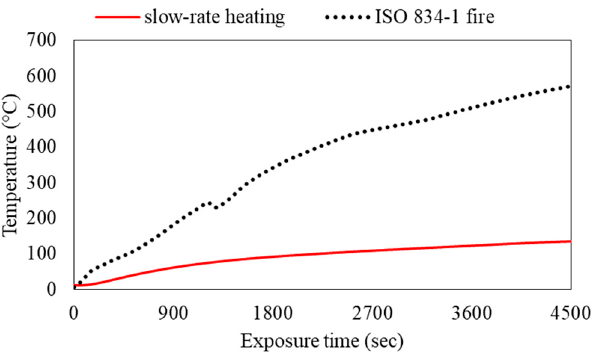
Figure 4. Evolution of the temperature of concrete at 10 mm from exposed surface.